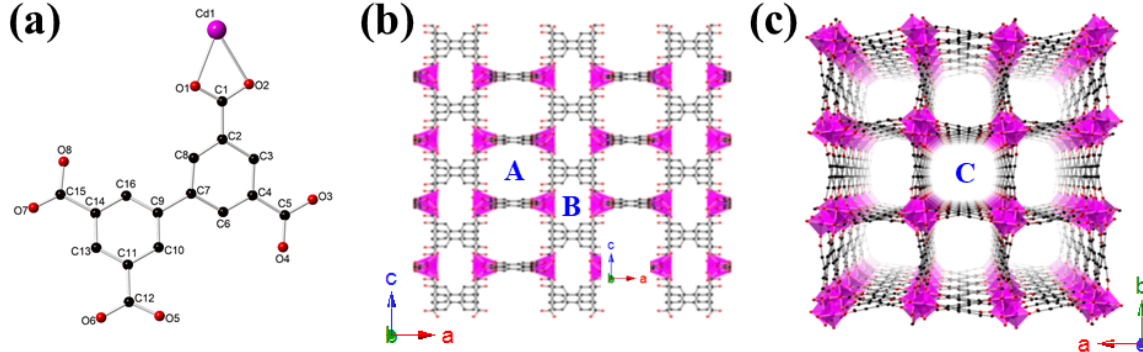
Figure 1. The asymmetric unit of CdBPTC (Cd, magenta; O, red; C, black) ( a ) and its polyhedral view of the 3D structure along b axis ( b ) and c axis ( c ). Table 1. Crystal data and structure refinement results for CdBPTC .